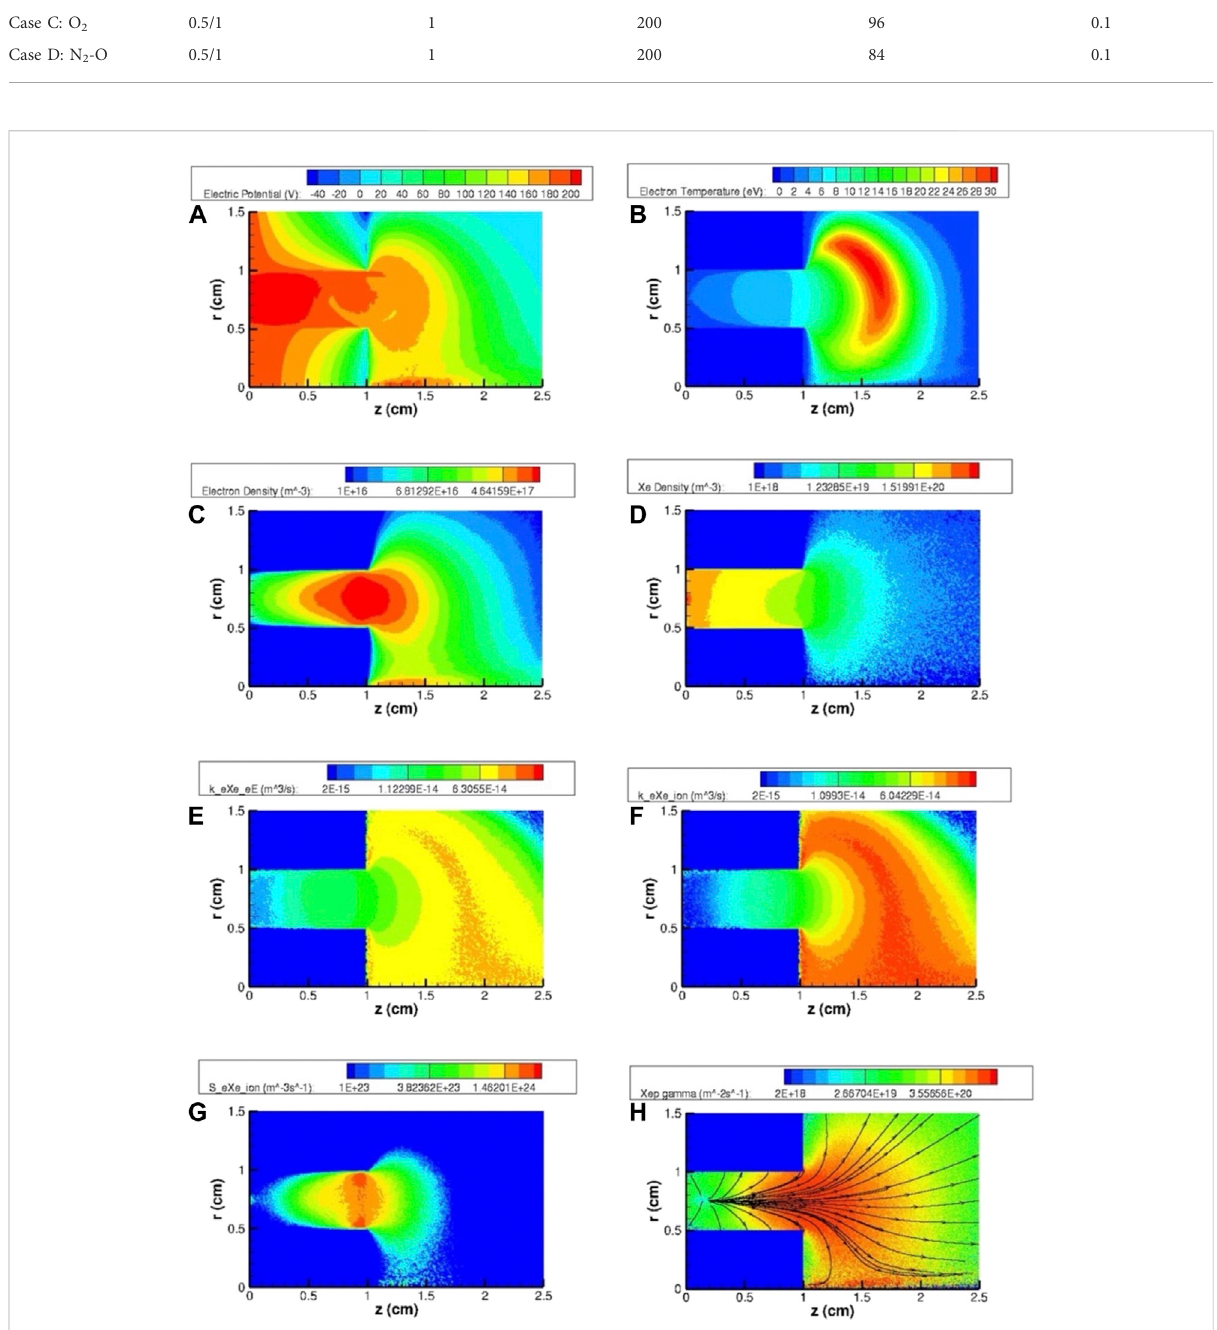
FIGURE 7 Two-dimensional maps of the most relevant HT plasma and gas parameters for the SPT20 nominal case using Xe (case A) as the propellant: (A) electricpotential ϕ (V), (B) electrontemperature T e (eV), (C) electrondensity n e (m − 3 ), (D) atomicdensity n Xe (m − 3 ), (E) and (F) electronicexcitationand ionization rate coef fi cients, k eE , Xe and k ion , Xe (m 3 s − 1 ) (Eq. 18), (G) ionization source term S ion , Xe (m − 3 s − 1 ) and (H) ion fl ux Γ Xe + (m − 2 s − 1 ) obtained by averaging over the last 1500 PIC cycles for plasma quantities (A – C,E – H) and over the last 1500 TPMC iterations for gas quantity (D)